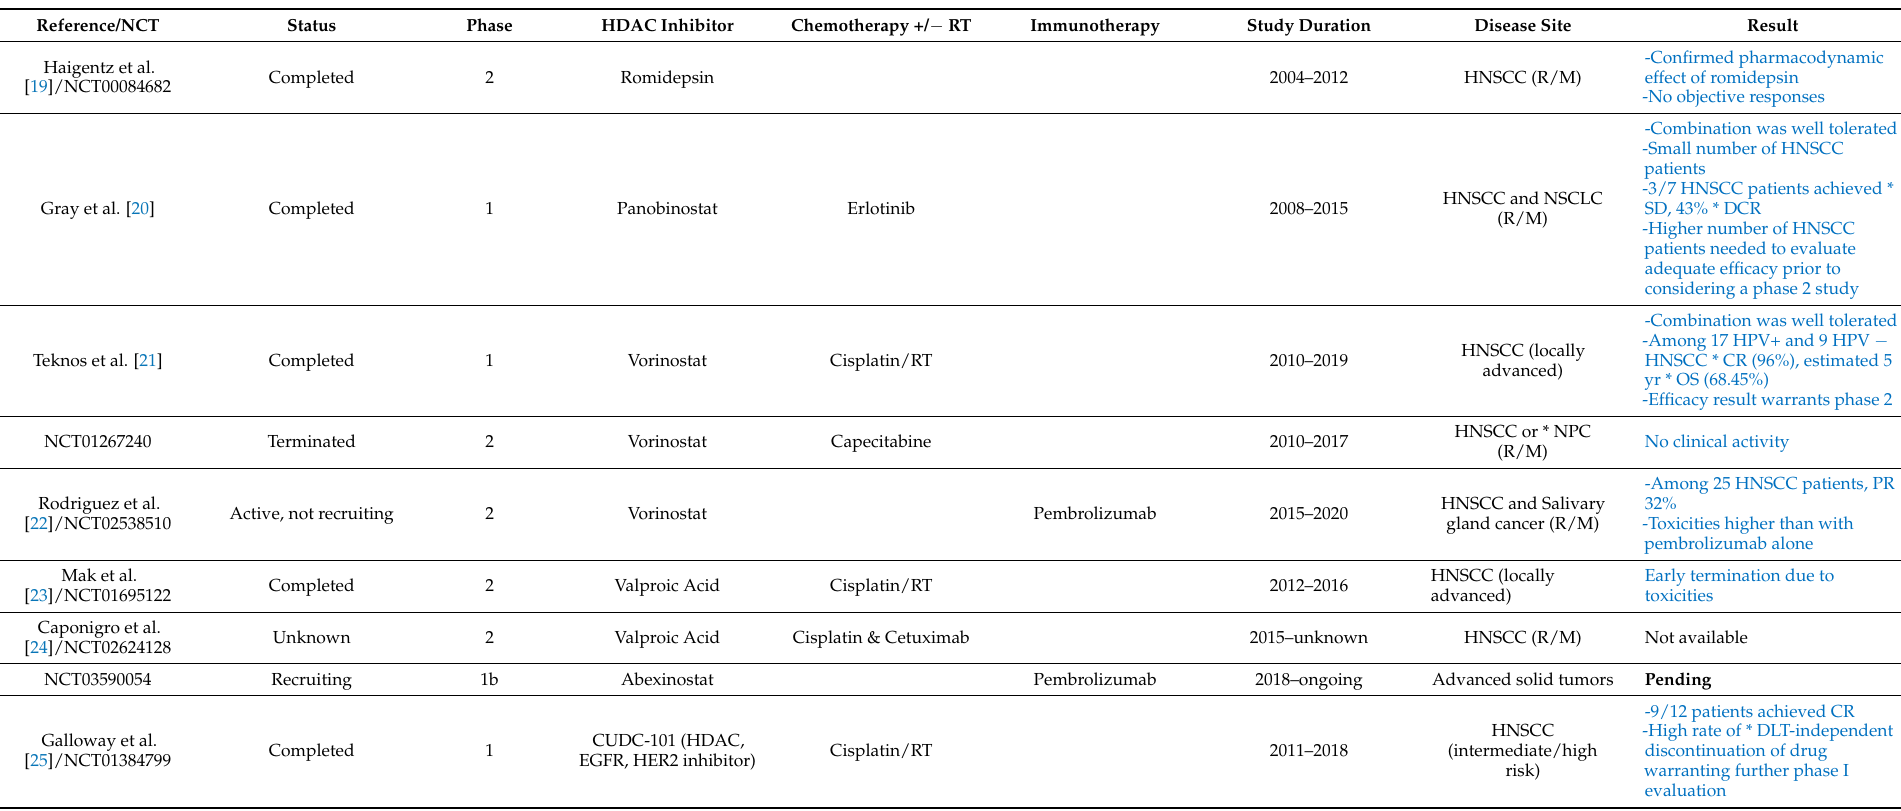
Table 3. Overview of clinical trials using HDAC inhibitors (monotherapy or combination) in